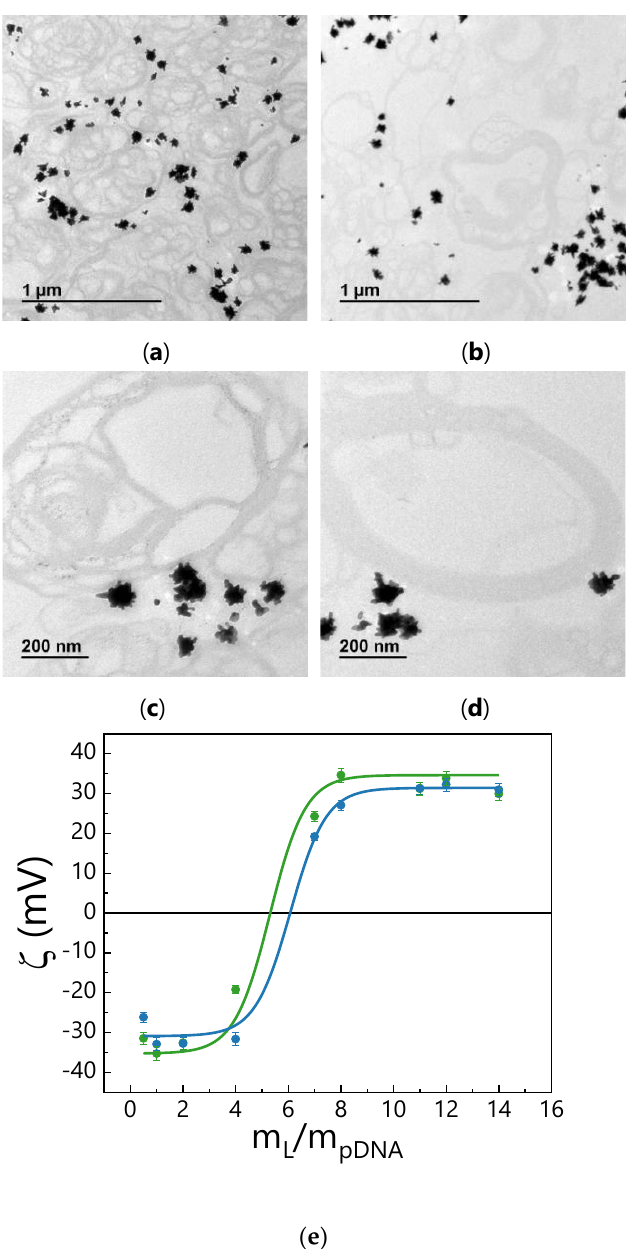
Figure 2. Stained TEM micrographs of the liposome-AuNS ( a , c ) and lipoplex-AuNS ( b , d ) systems and ( e ) ζ –potential versus m L /m pDNA of the lipoplex (green points) and lipoplex-AuNS (blue points) systems.